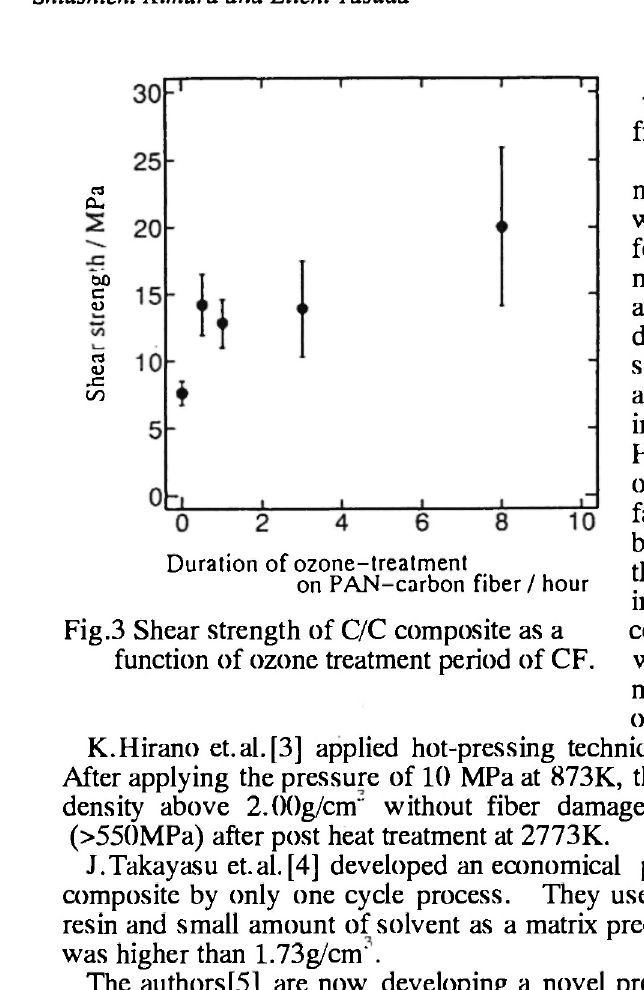
Fig.3 Shear strength of C/C composite as a function of ozone treatment period of